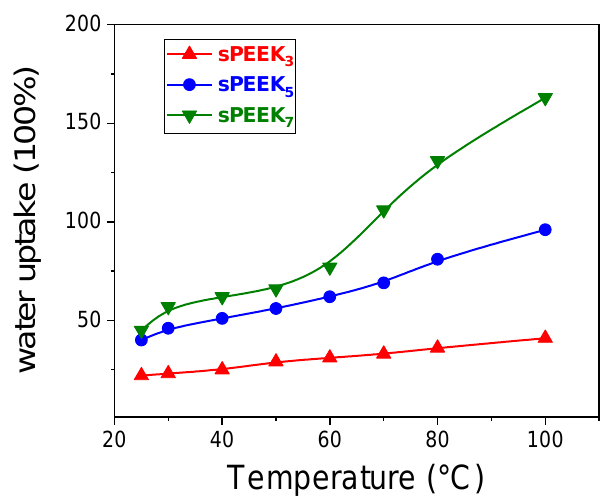
Figure 4. Water uptake of sPEEK membranes at different DS versus temperature, in the range 25–100 °C.